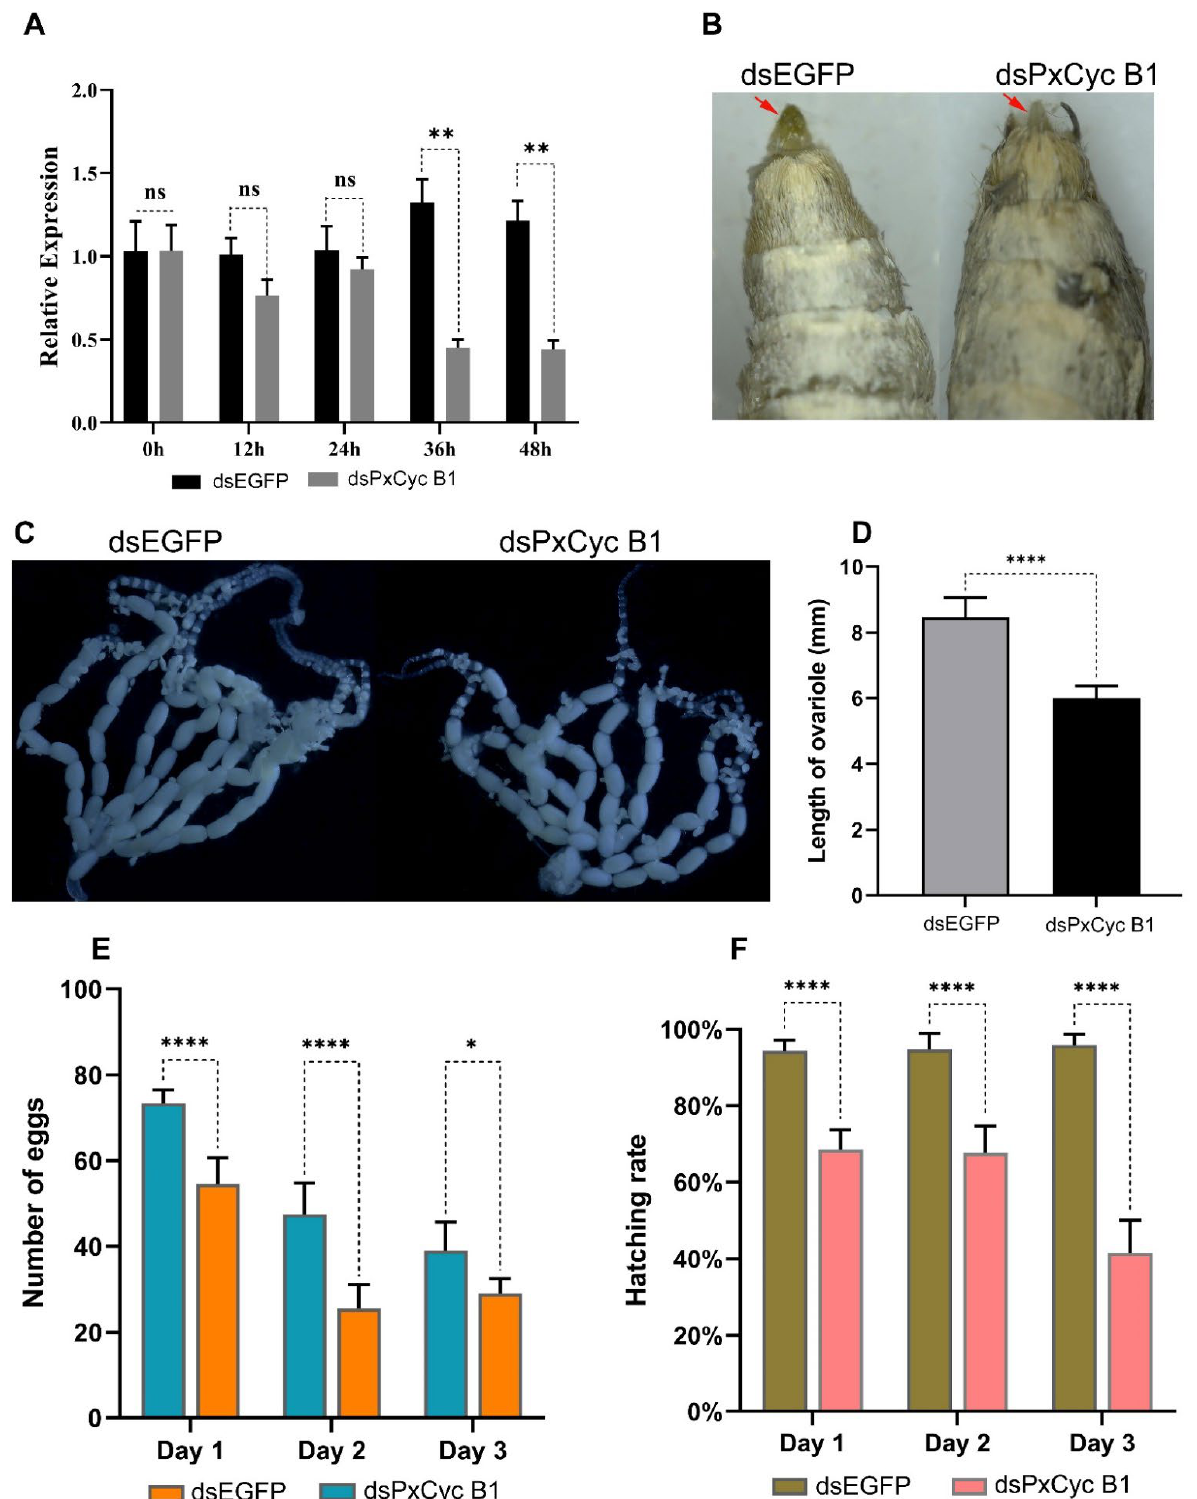
Figure 8. RNAi analysis of PxCyc B1 . ( A ), relative expressions of PxCyc B1 at different time points after dsRNA injections; ( B ), phenotypic differences in external genitalia after dsRNA injections; ( C ), differences in ovary between dsPxCyc B1 and dsEGFP, ( D ), length of ovariole; ( E ), the difference in the number of eggs laid by females injected with dsPxCyc B1 and dsEGFP, ( F ), the difference in hatching rate. Bars represent the mean ± SEM of at least three biological replications. Significant differences were highlighted with asterisks; **** indicates the highly significant difference at p < 0.001; ** indicates the significant difference at p < 0.01; * indicates the significant difference at p < 0.05; and ns for the non-significant